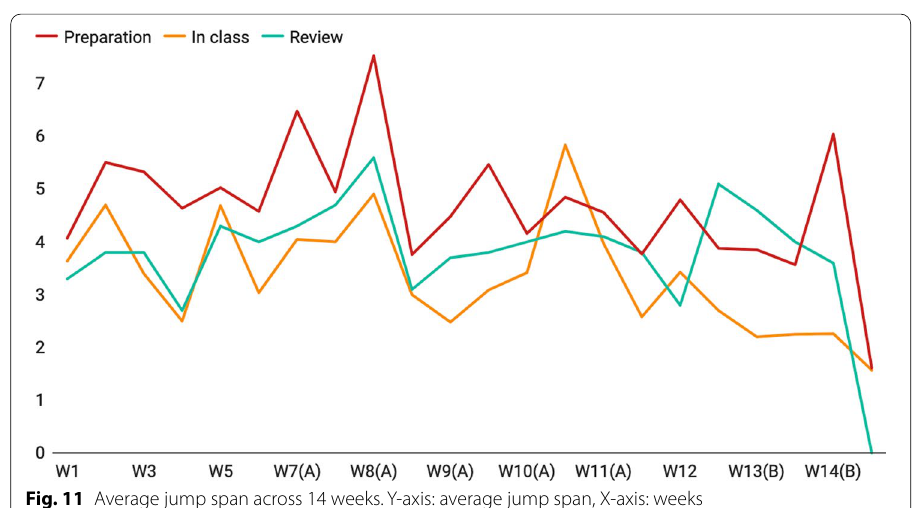
Fig. 11 Average jump span across 14 weeks. Y-axis: average jump span, X-axis: